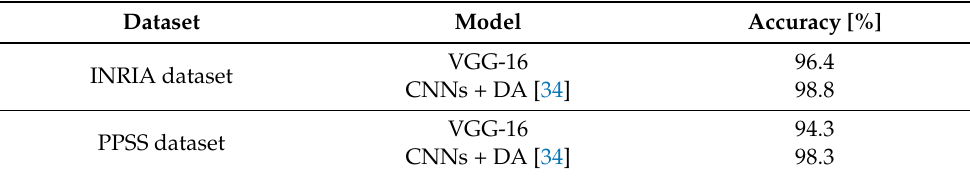
Table 7. The results of Human segmentation on the INRIA dataset and PPSS dataset